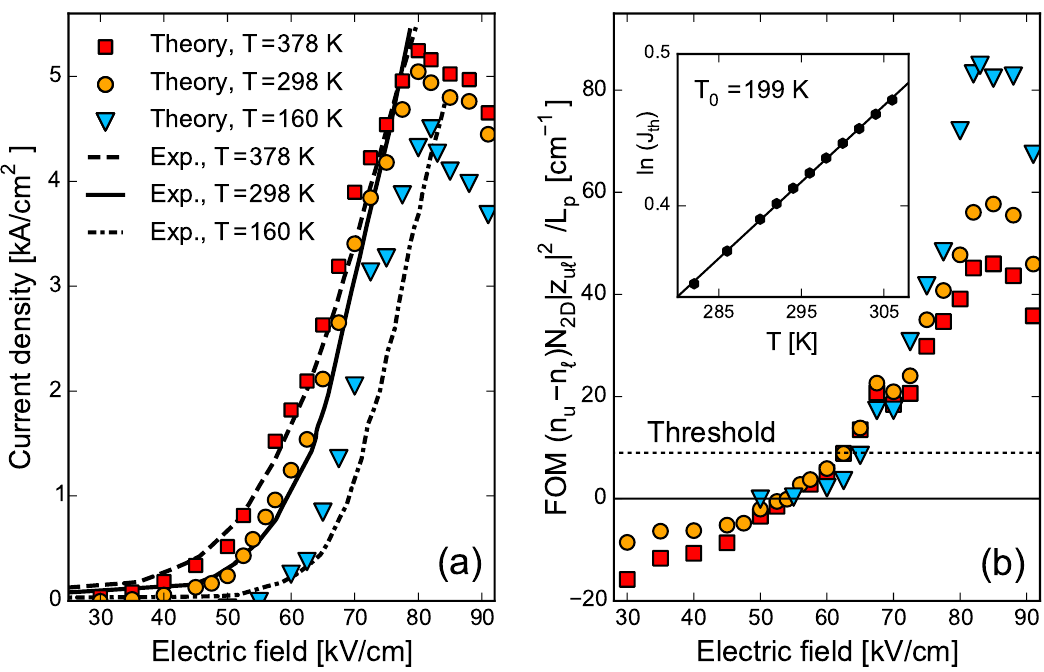
Figure 3. ( a ) Calculated (symbols) and measured (lines) current density vs. electric field characteristics at different temperatures (378, 298, and 160 K); ( b ) figure of merit (FOM) (proportional to modal gain) vs. electric field at different temperatures. The reported threshold current density of 1.53 kA/cm 2 at a temperature of 298 K corresponds to a field strength of 62.5 kV/cm and FOM th = 9 cm − 1 (dashed horizontal line), which is slightly above the onset of population inversion (54 kV/cm, FOM = 0). ln ( J th ) = ln ( J 0 ) + T / T 0 with T 0 = 199 K (solid line). Experimental data from